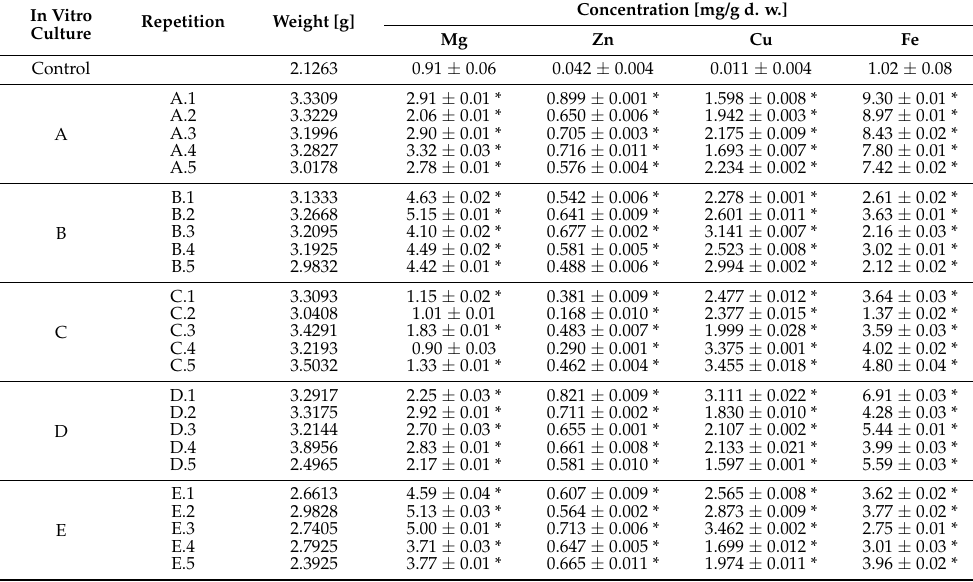
Table 3. Results of measurement of biomass growth and metal accumulation in five selected in vitro cultures of A. bisporus.